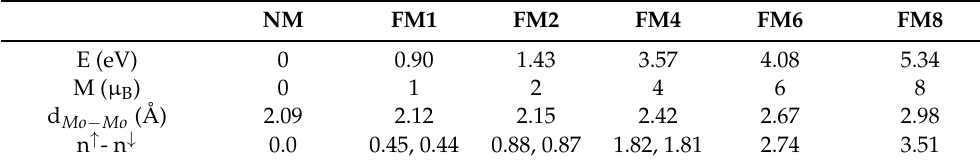
Table 1. GGA-PBE results for the MoMo molecule in the gas-phase. For each state, we report the total energy E (relative to the nonmagnetic ground state energy), the total magnetization M , the Mo-Mo distance d Mo − Mo and the magnetization on the d states of each Mo, n ↑ - n ↓ . Double entries in n ↑ - n ↓ refer to the Mo atoms, when they present different magnetizations. In the first row, the numbering at the end of the label refers to the corresponding value of M